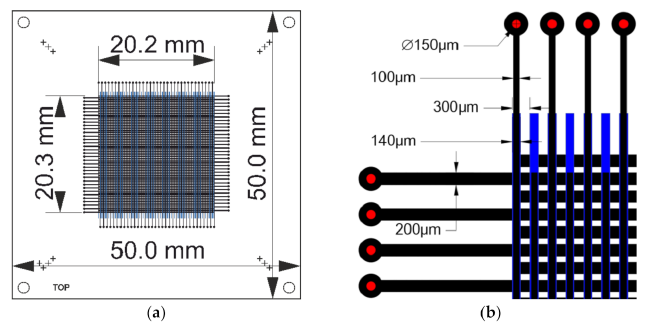
Figure 2. The design of electrode array: ( a ) outer dimensions of active sensing area and substrate; ( b ) dimensions of electrodes and spacing between them.